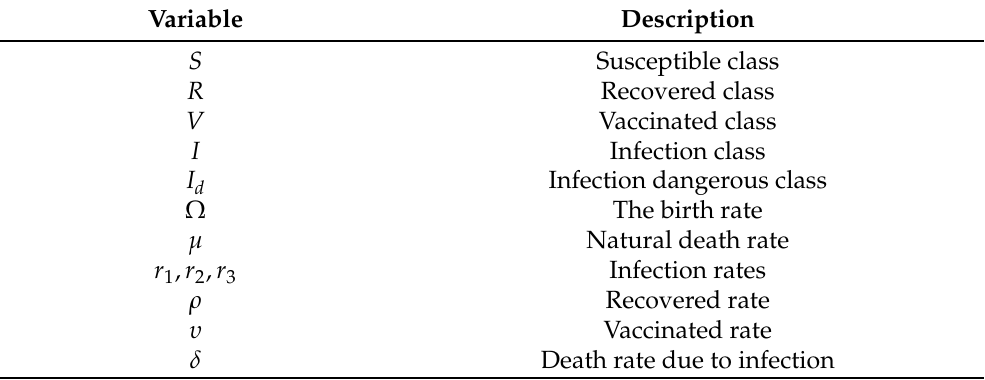
Figure 1. Diagram showing the transitions between categories. The proposed model’s flowchart and parameters description are explained in Table 1. Table 1. Parameters